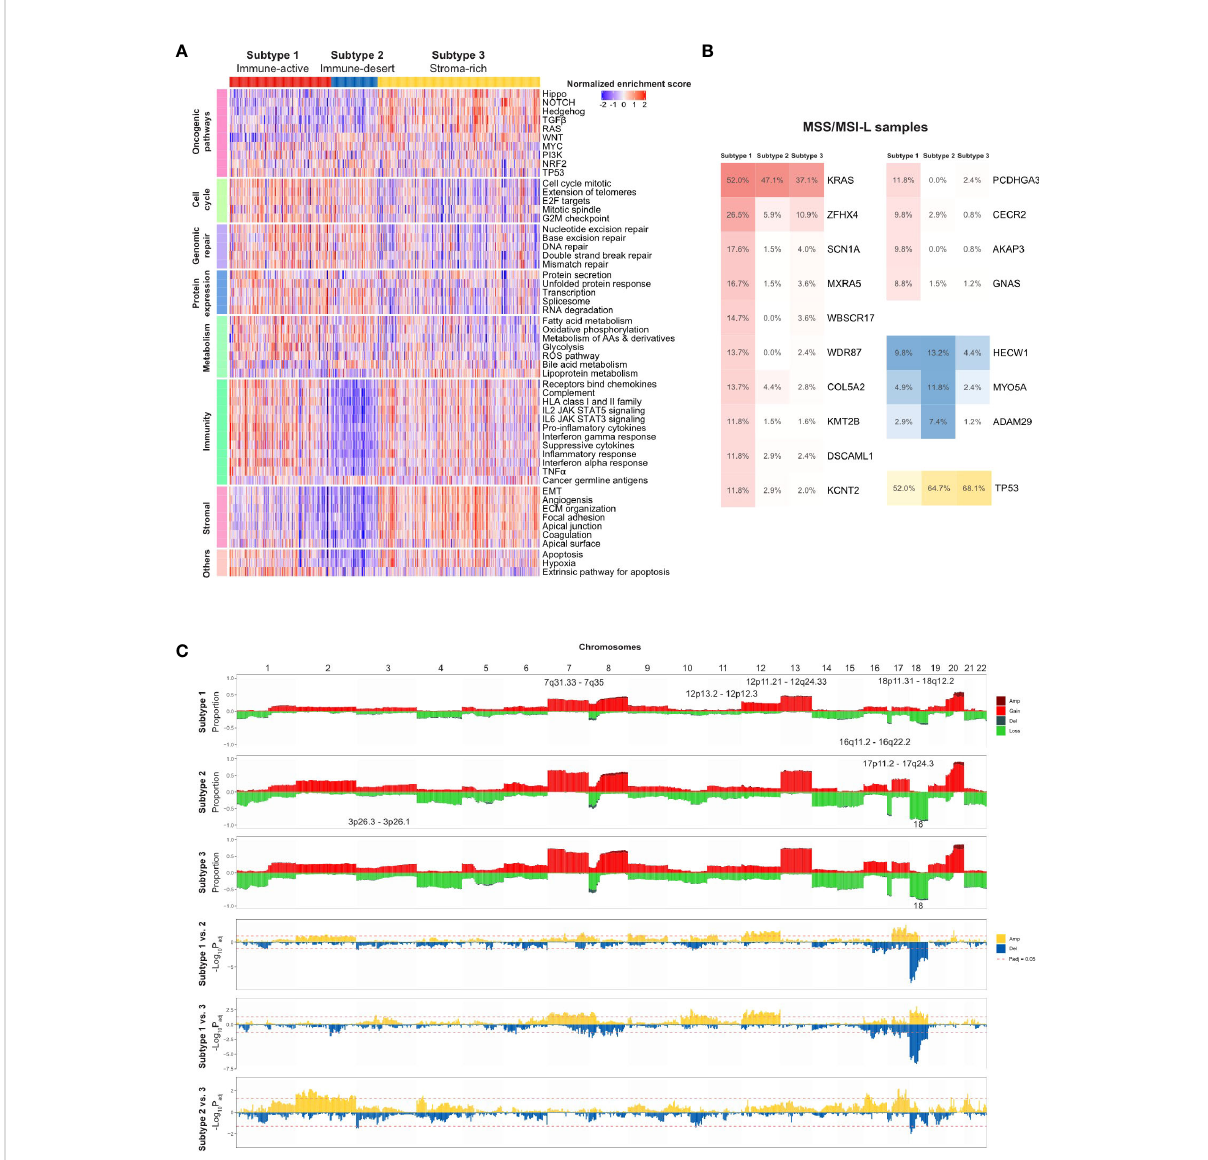
FIGURE 5 TMEC subtype-speci fi c genomic alterations in the TCGA cohort. (A) Heatmap illustrating activation of comprehensive cancer development- related pathways among three TMEC subtypes. (B) Subtype-speci fi c gene mutation frequency among MSS/MSI-L samples in three TMEC subtypes. (C) Subtype-speci fi c SCNVs of each TMEC subtype (top three plots) and comparison of SCNVs between every two